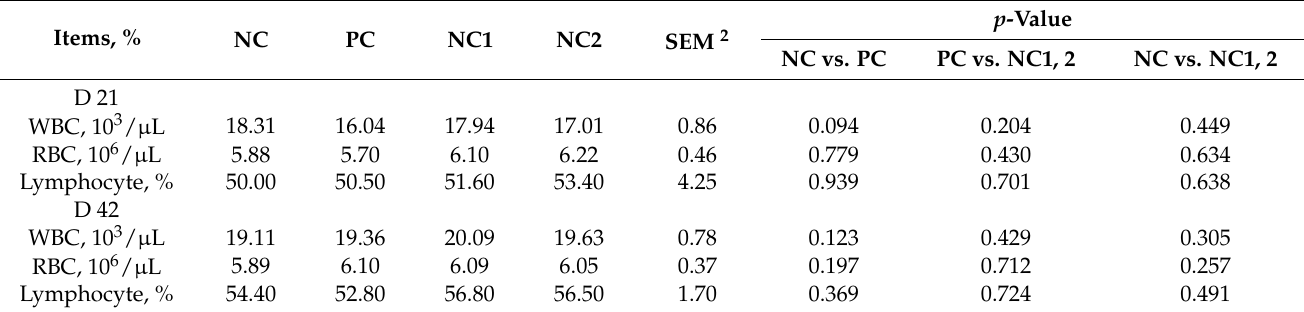
Table 4. Effect of dietary Lactobacillus plantarum BG0001 supplementation on blood profile in weaning pigs 1 . Items, %